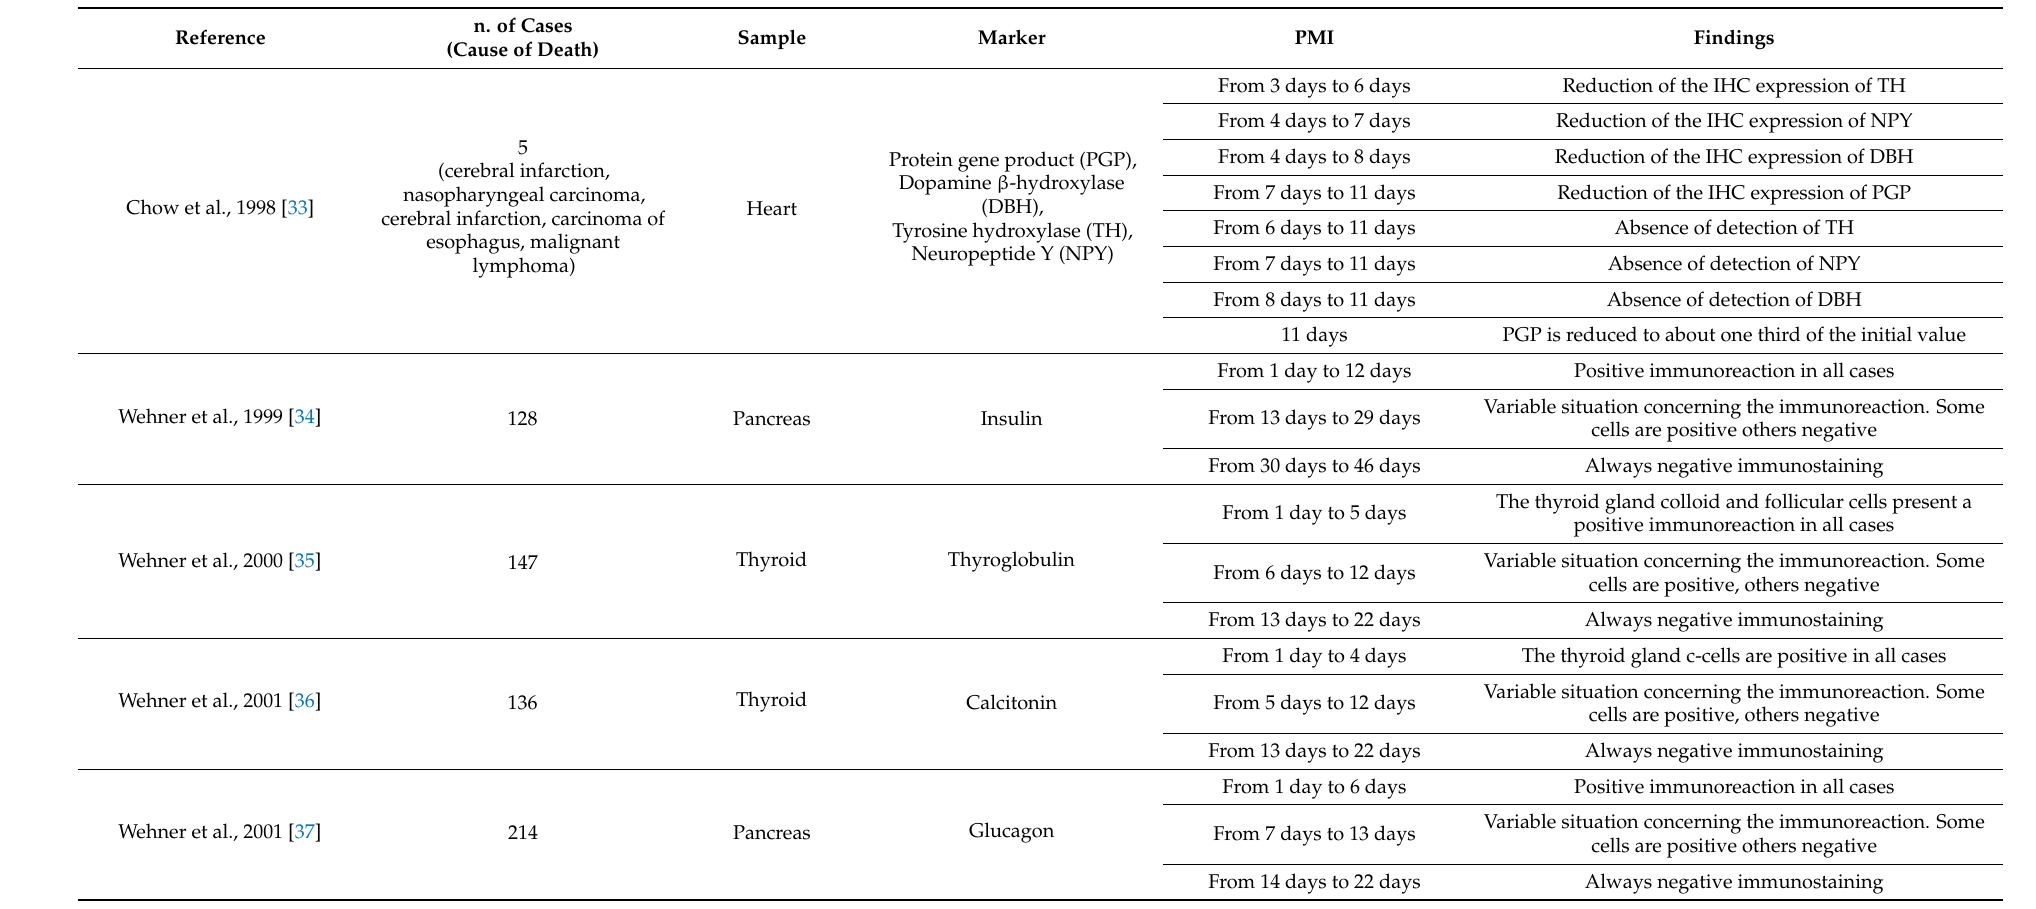
Table 1. Summary of the results of the systematic